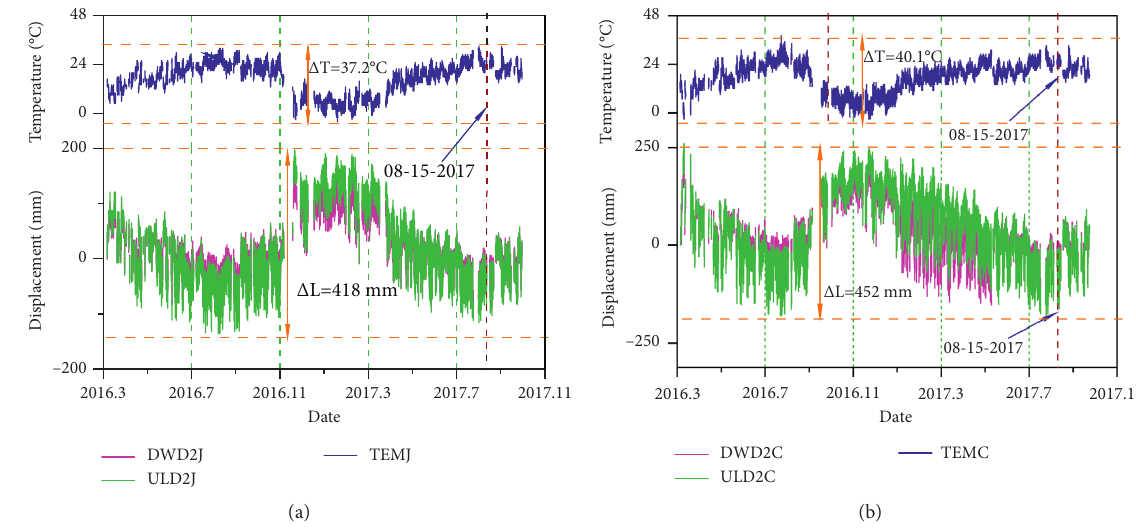
Figure 5: Displacement and temperature measured during monitoring period: (a) Jishou side; (b) Chadong side.